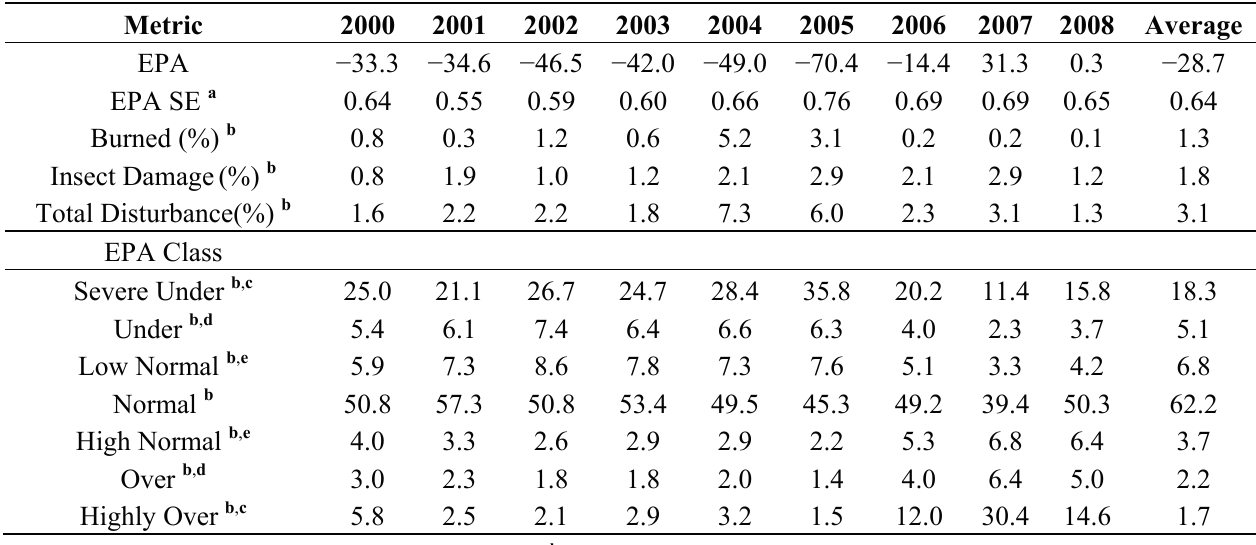
Table 1. Average Ecosystem Performance Anomaly (EPA) values for 2000–2008, yearly area (%) impacted by fire and insects, and area (%) in each EPA performance class for Yukon River Basin boreal